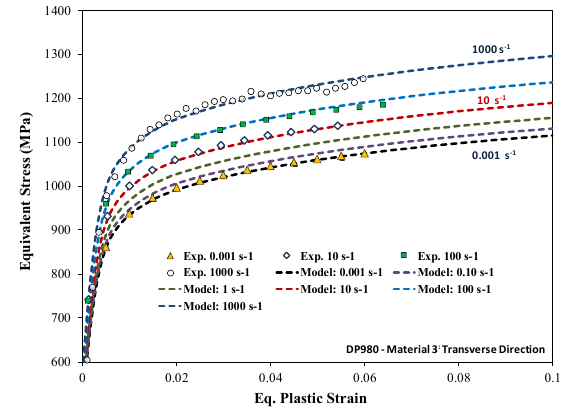
Fig. 19. Comparison of experimental and CS predicted equivalent stress and equivalent plastic strain for Material 3.